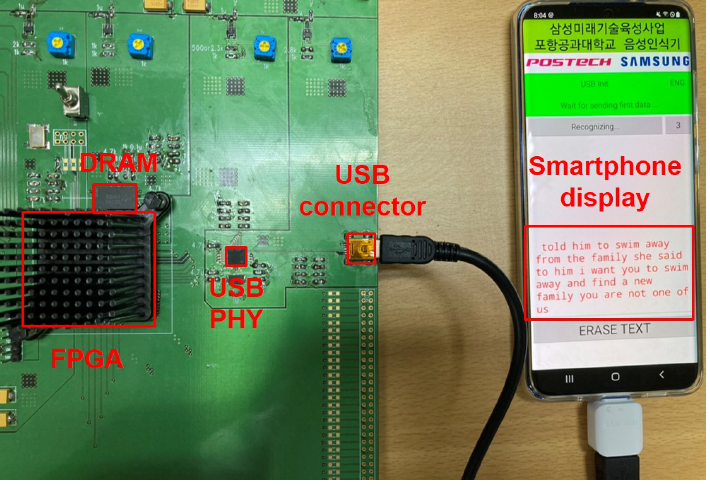
Figure 8. The ASR system board of this